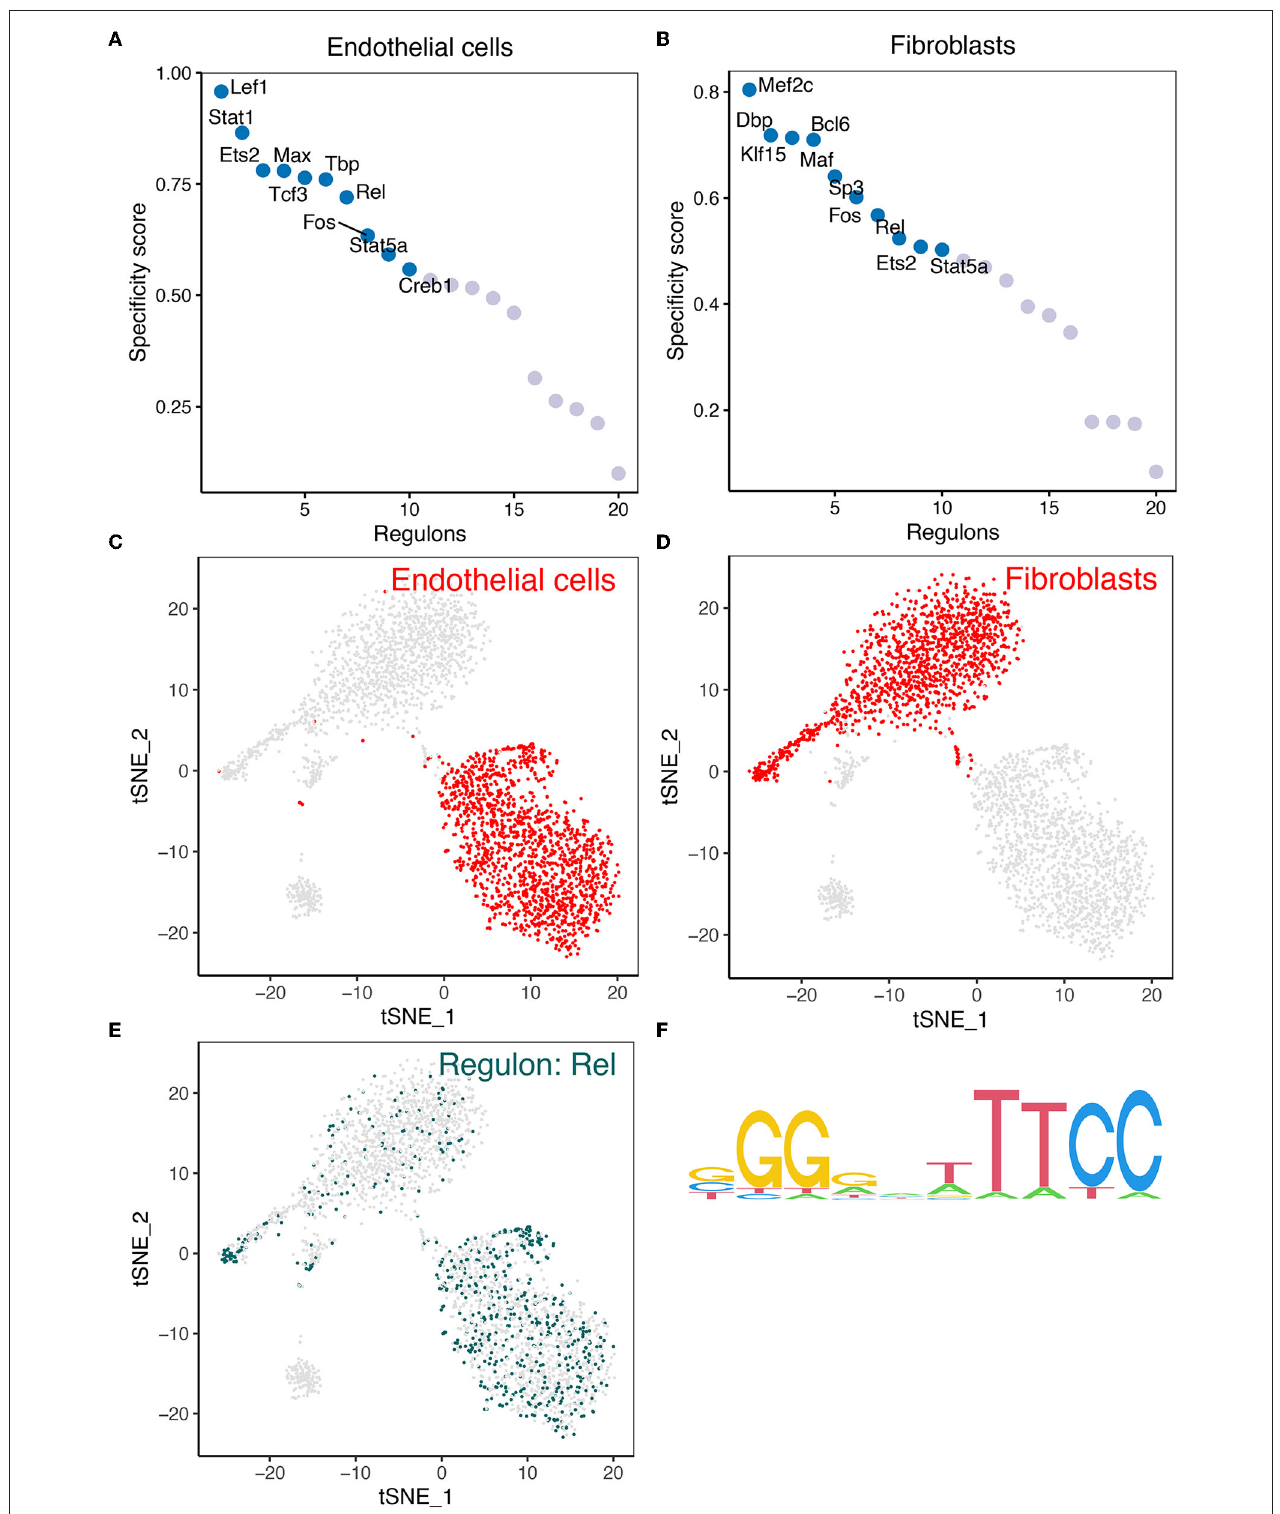
FIGURE 4 | The findings of the SCENIC investigation of REL. (A) The regulon specificity score was used to rate the various regulators in endothelial cells. (B) The regulon specificity score was used to rank the various regulators in fibroblasts. (C) In the tSNE map, endothelial cells are visible. (D) Fibroblasts are visualized in the tSNE map. (E) REL was discovered to be significantly expressed in endothelial cells and fibroblasts. As can be seen, endothelial cells have greater levels of REL expression than fibroblasts. (F) Base distribution in REL-functioning motifs.